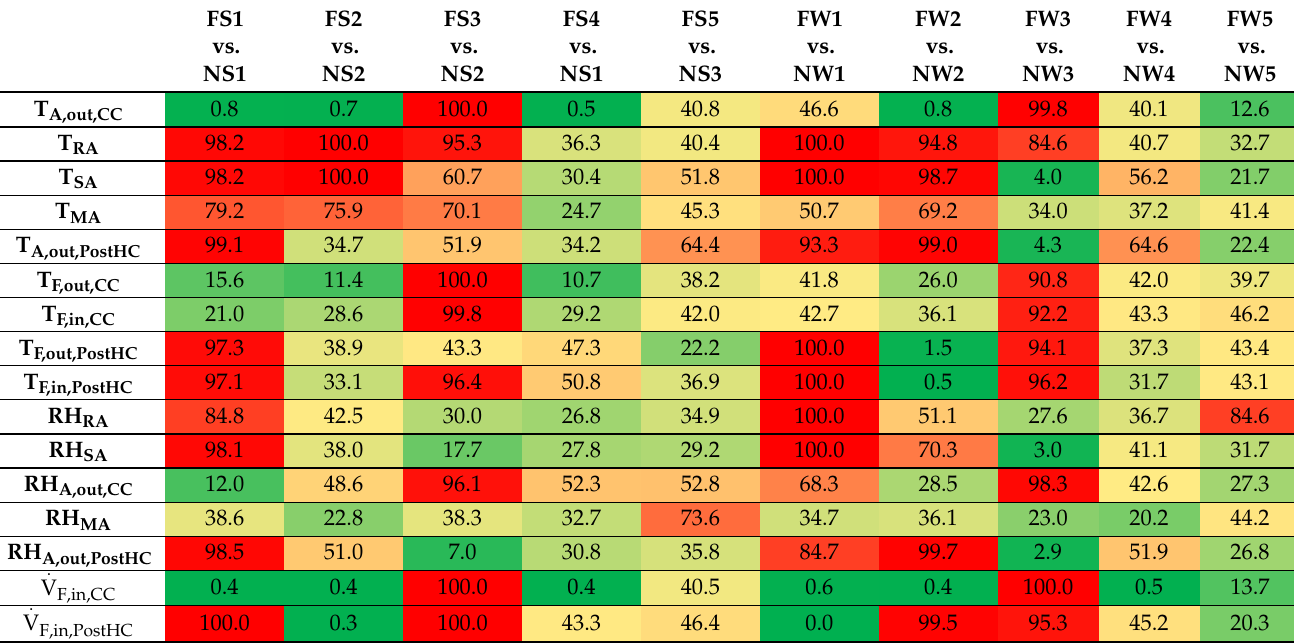
Table 7. Symptom occurrence probability (SOP) as a function of tests and measured